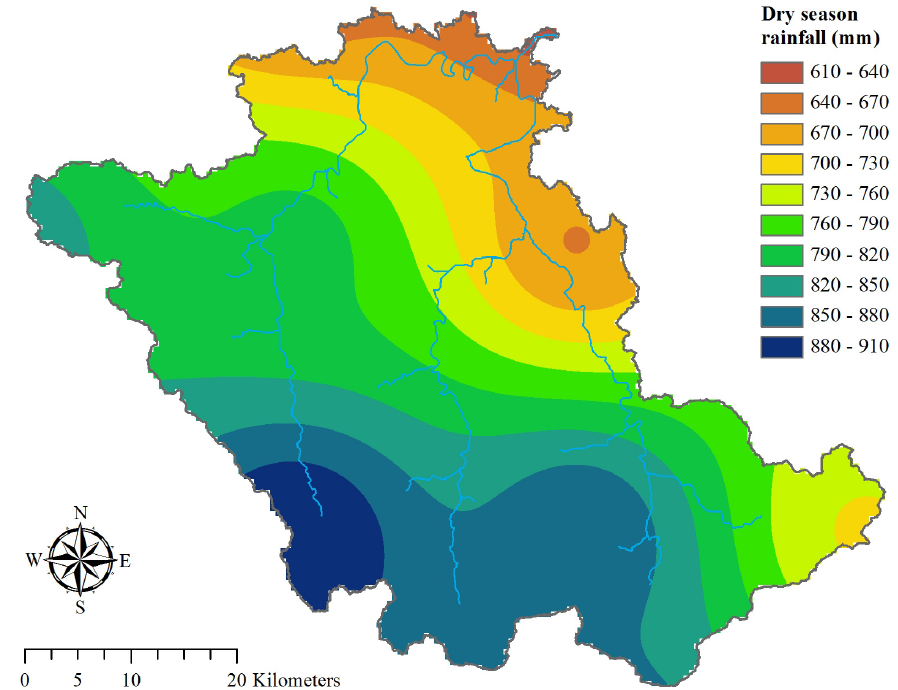
Figure 4. Average rainfall in the dry season for the period of